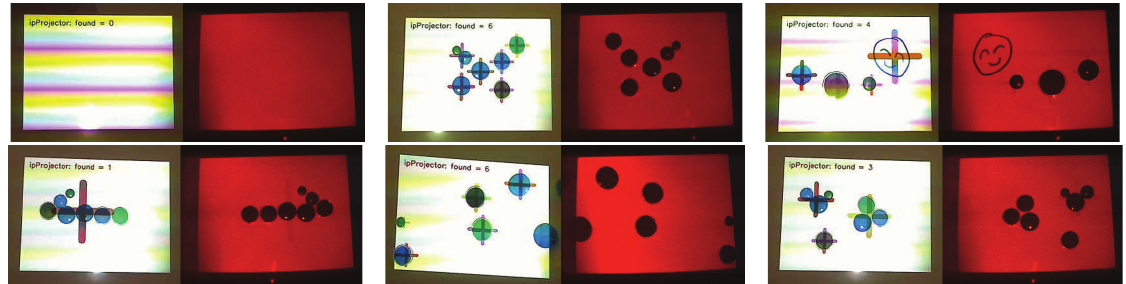
Figure 13: Demonstration of the ipProjector concept. Left images are snapshots of the surface taken by a separated camera. Right images are images captured by the system